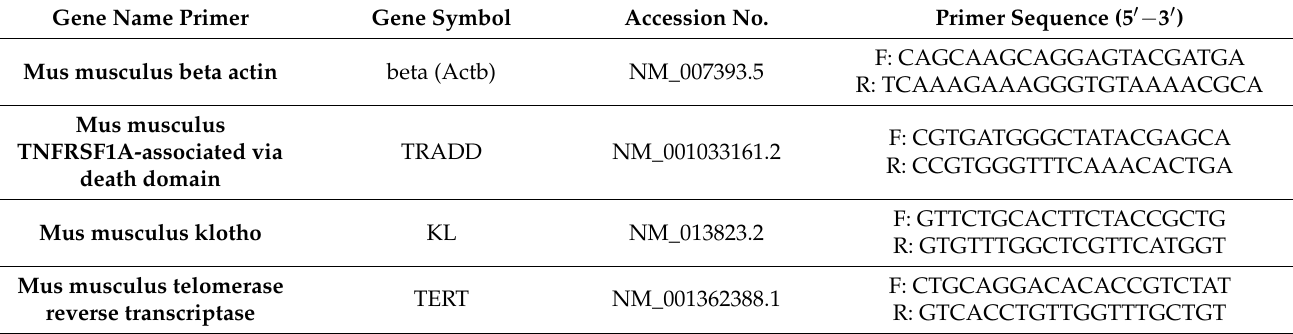
Table 5. The primers of genes used for